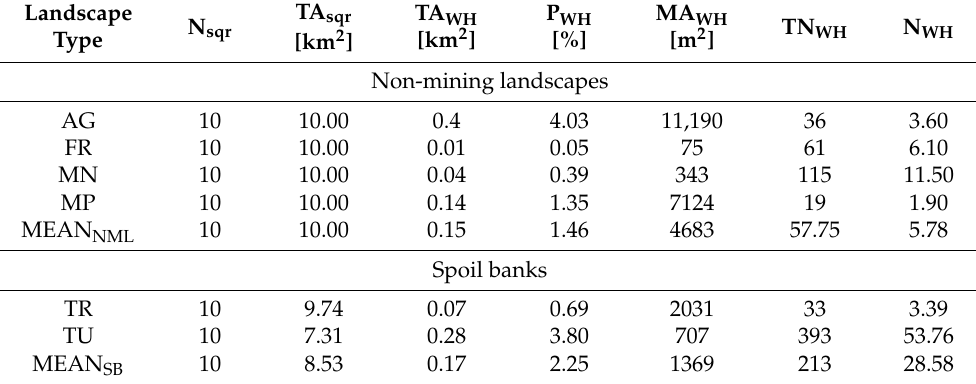
Table 2. Quantities (i.e., numbers and proportions) of water habitats (WH) area in assessed land- scape types (LT). AG = agricultural landscape; FR = forest landscape; MN = mountain landscape; MP = meadows and pastures; TR = technically reclaimed spoil banks; TU = technically unreclaimed spoil banks. N sqr = number of assessed squares per LT; TA sqr = total area of selected squares in km 2 ; TA WH = total area of WH per LT in km 2 ; P WH = proportion of WH area per LT in percent; MA WH = mean area of WH per LT in m 2 ; TN WH = total number of WH per LT; N WH = number of WH per LT per km 2 ; MEAN NML = mean values for non-mining landscapes (counting from the TA sqr , TA WH , and TN WH of all non-mining landscapes); MEAN SB = mean values for spoil banks (counting from the TA sqr , TA WH , and TN WH of all spoil